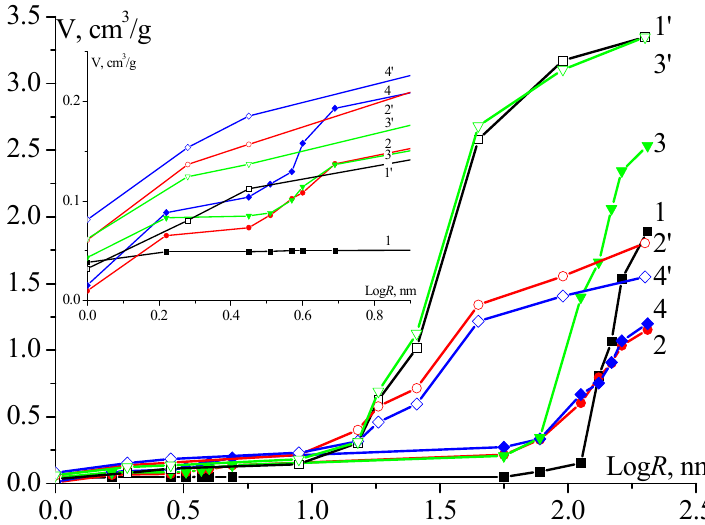
Figure 2. Integral curves of specific pore volume distribution V with respect to effective radii R (porometric curves) obtained with water (1, 2, 3, 4) and octane (1 ′ , 2 ′ , 3 ′ , 4 ′ ) for CNT-1(1, 1 ′ ), CNT-2(2, 2 ′ ), CNT-3(3, 3 ′ ), and CNT-4 (4, 4 ′ ). The insert in the figure corresponds to the porometric curves in the area of micropores. Table 2. Electrical conductivity and electrochemical characteristics of modified